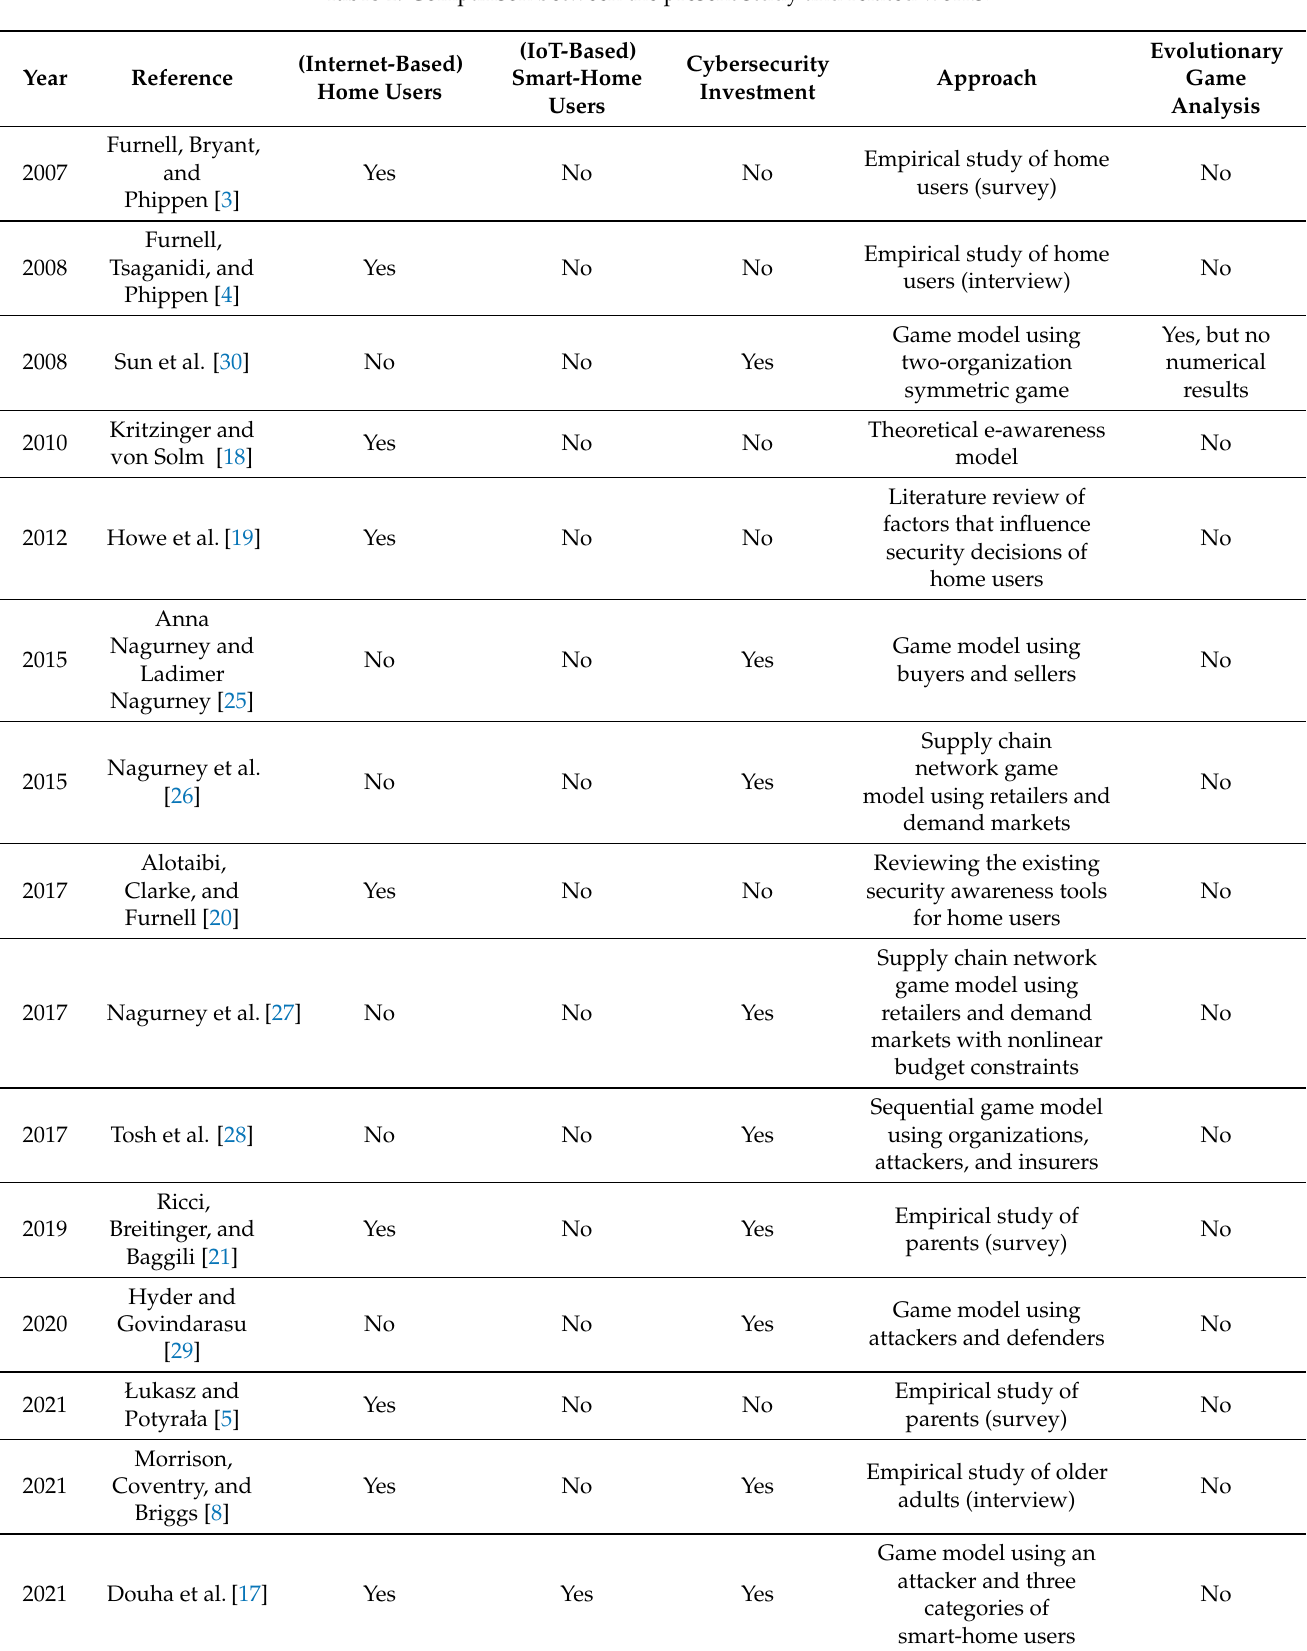
Table 1. Comparison between the present study and related